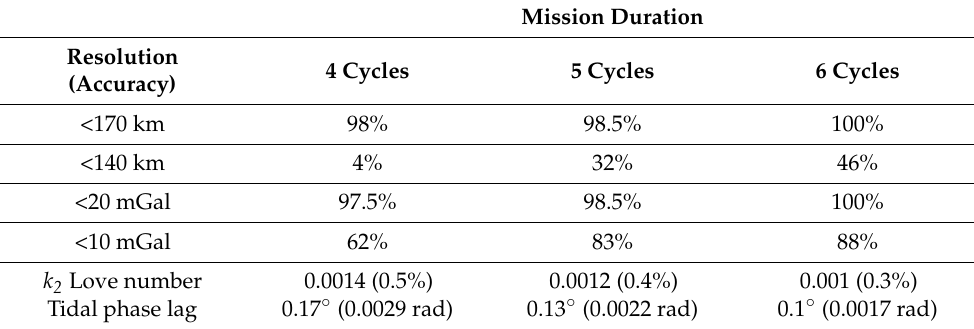
Table A3. Planetary surface percentage with a given spatial resolution of the expected EnVision gravity field solution and the error (1- (cid:2763) ) on the expected Love number k 2 and tidal phase lag solutions versus the mission duration.